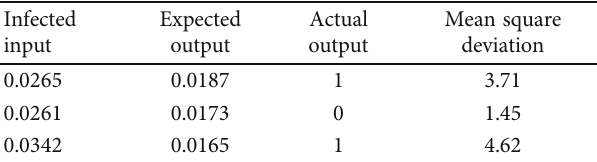
Table 2: Robustness